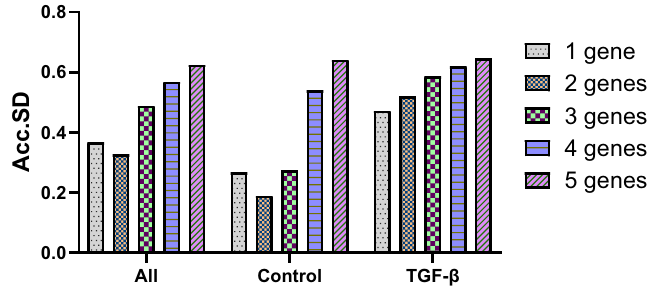
Figure 4. Optimal number of housekeeping genes according to GenEx software analysis. Accumulated standard deviation (Acc.SD) for the five candidate reference genes in all groups to estimate the ideal number of genes for normalization. Lower values of Acc.SD indicate the optimal number of reference genes. All, all